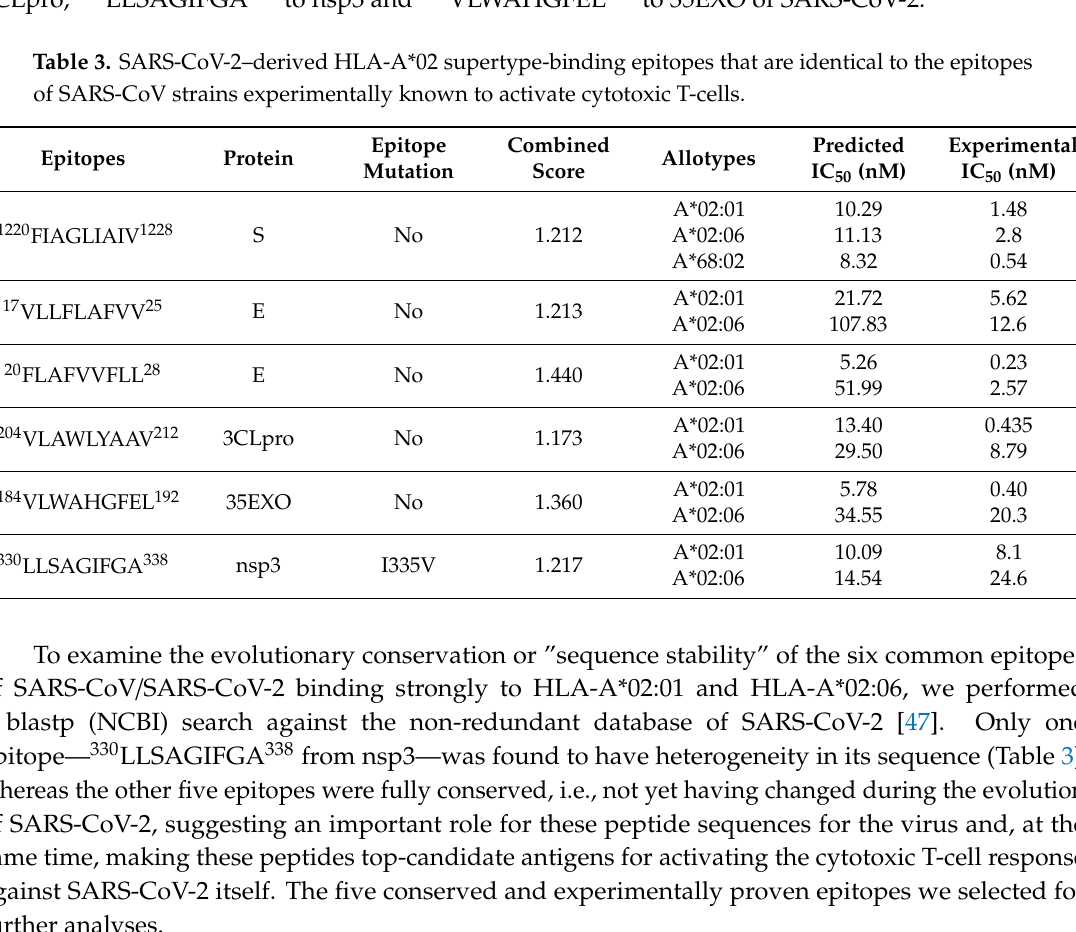
Predicted Epitope Combined Allotypes IC 50 (nM) Mutation Score